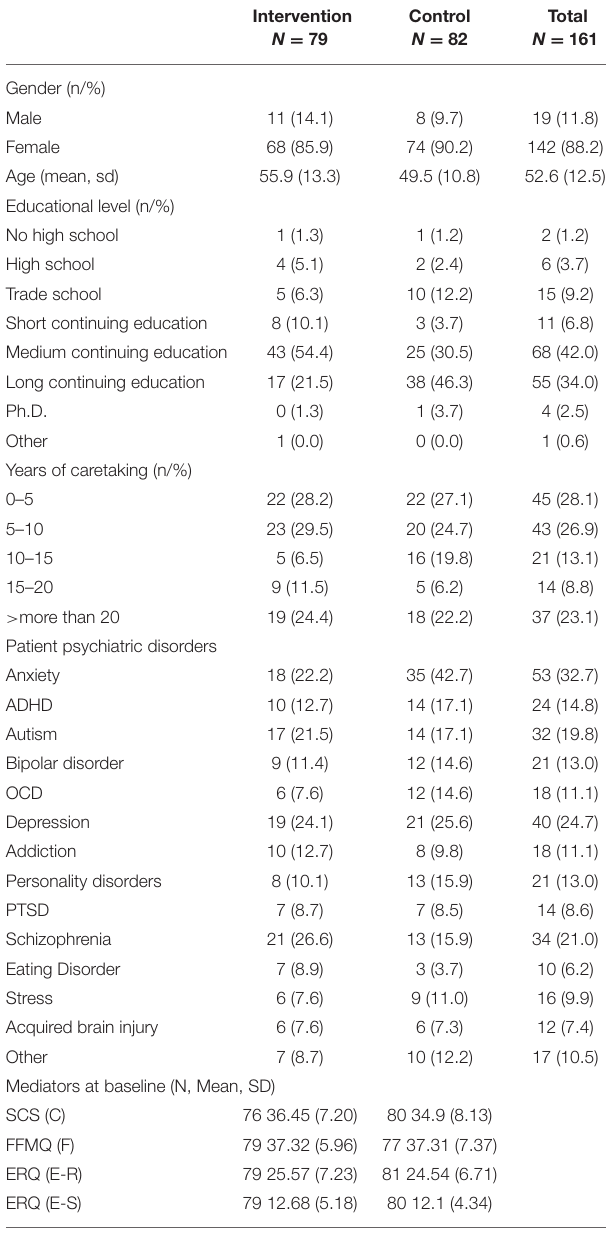
TABLE 1 | Demographic characteristics of caregivers at